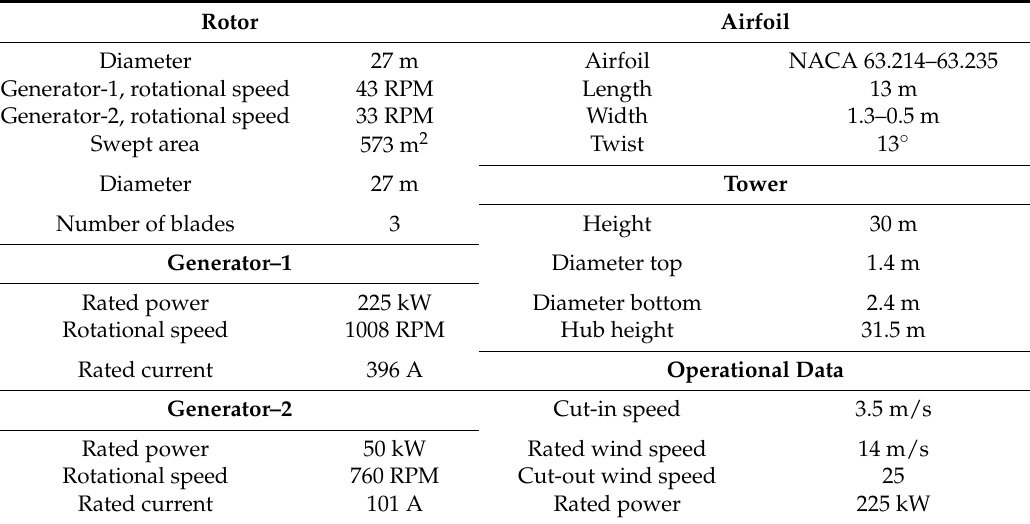
Figure 4. Power curve of the V-27.